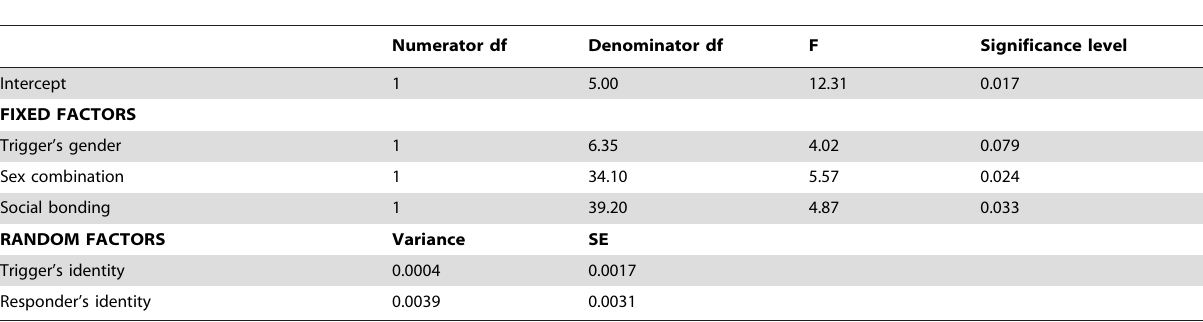
Table 2. Best LMM explaining the occurrence of yawn contagion within the first minute (AICc = 2